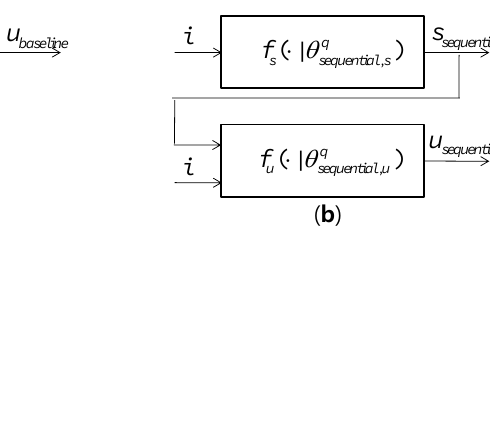
Figure 1. The structure of the proposed DL-based consensus control ( a ) baseline DL; ( b ) sequential DL; ( c ) disjoint DL; ( d ) joint